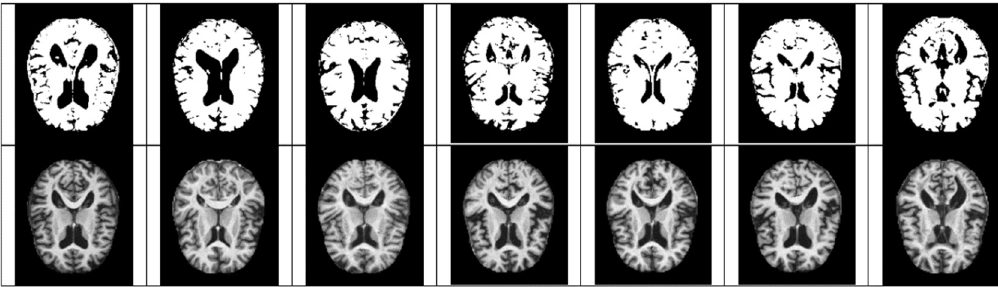
Figure 3. Quantized very mild examples ( above ), original very mild examples ( below ).